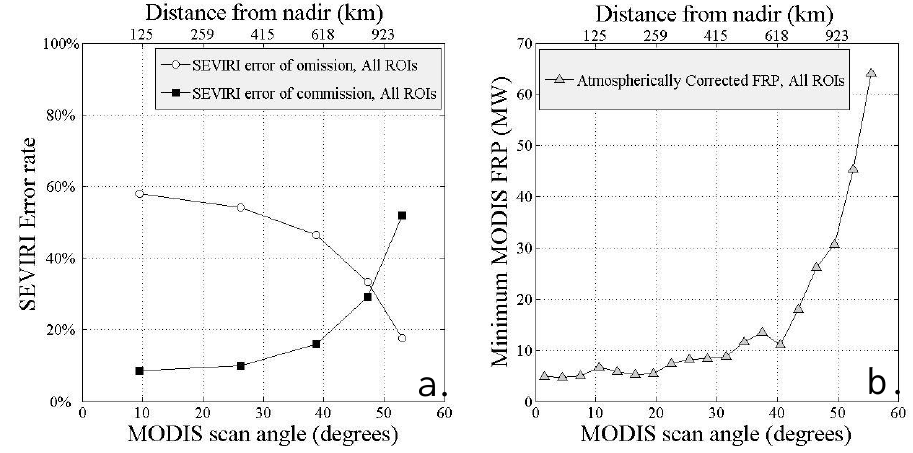
Figure 10. In ( a ) are seasonal SEVIRI errors of omission and commission evaluated for all regions of interest (ROIs) as a function of MODIS scan angle. In ( b ) is the minimum atmospherically corrected FRP detected by MODIS over all ROIs as a function of MODIS scan